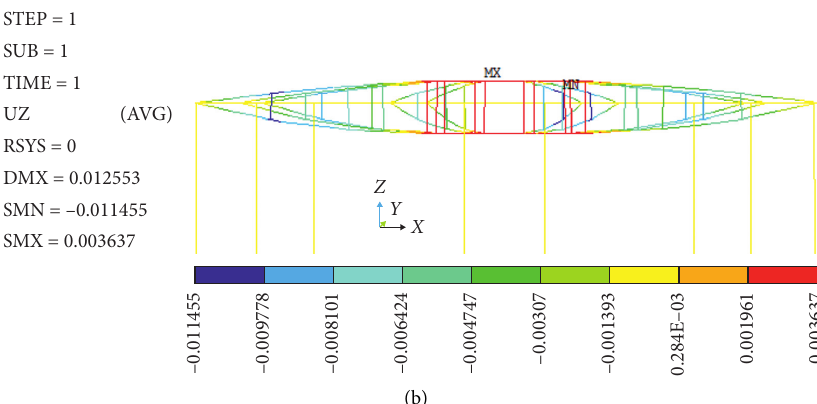
Figure 11:1.0 constant load+full span 1.0 live load real-time simulation analysis diagram. (a) Model internal force diagram (N). (b) Model displacement diagram (m).